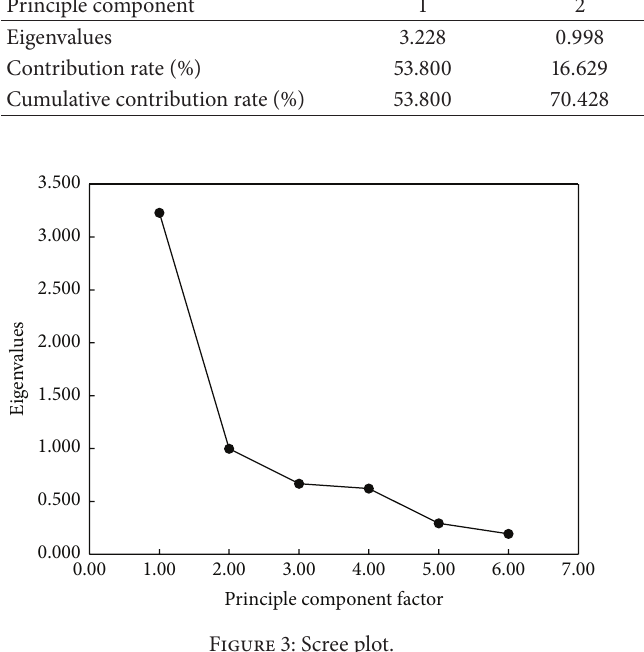
Figure 4: Three-dimensional loading plots of heavy metals.